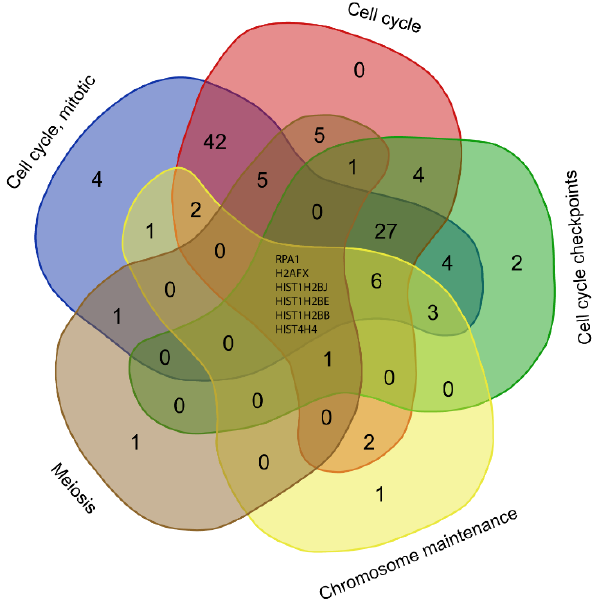
Figure 3. Common DEGs involved in the cell cycle pathways due to polymyxin B treatment. DNA replication and repair were also significantly perturbed across 23 up-regulated genes (Tables 1 and S1). Nine up-regulated genes involved in DNA replication were iden- tified using both KEGG and Reactome, including helicase encoding gene DNA2 , ligase encoding gene LIG1 , minichromosome maintenance complex components MCM4 and MCM6 , DNA polymerases POLA2 and POLD3 , replication factors RFC2 and RFC5 , and replication protein RPA1 . In the significantly enriched KEGG pathways, the Fanconi ane- mia, mismatch repair and homologous recombination pathways were associated with DNA repair. By mapping DEGs to these three pathways in KEGG and to DNA repair pathways in Reactome, 19 shared genes were identified (Figure 4). The mineral absorption pathway in KEGG was significantly enriched by 8 up-regulated DEGs, comprising 6 metallothionein-encoding genes ( MT1A , MT1B , MT1E , MT1F , MT1H and MT1X ), the sul- phate/anion transporter gene SLC26A9 , and the zinc transporter gene ZNT1 (Table 1).